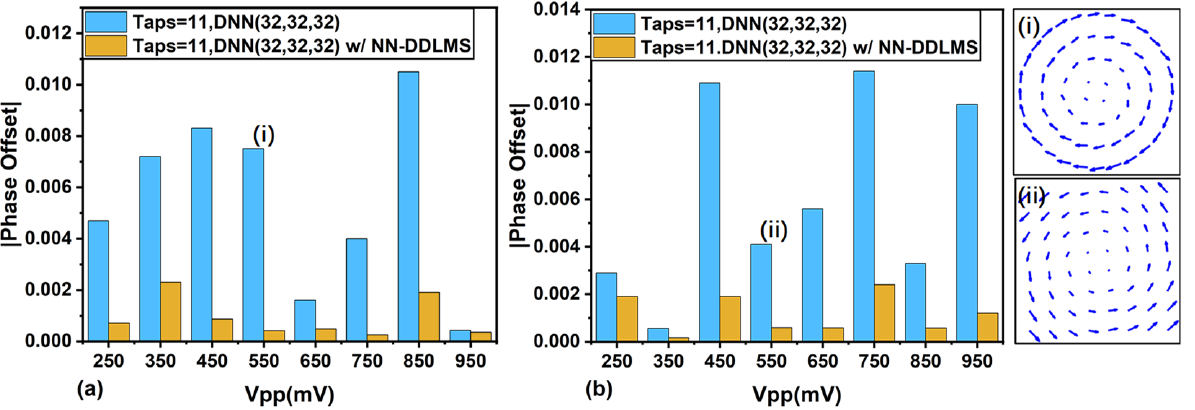
Figure 9. Phase Offset of DNN (32, 32, 32) with taps of 11 for ( a ) 64APSK; ( b ) 64QAM UVLC systems under different signal Vpp. ( i , ii ) show the movement vector of each constellation points’ center after NN-based DD-LMS for 64APSK and 64QAM systems when signal Vpp is 550 mV, respectively.